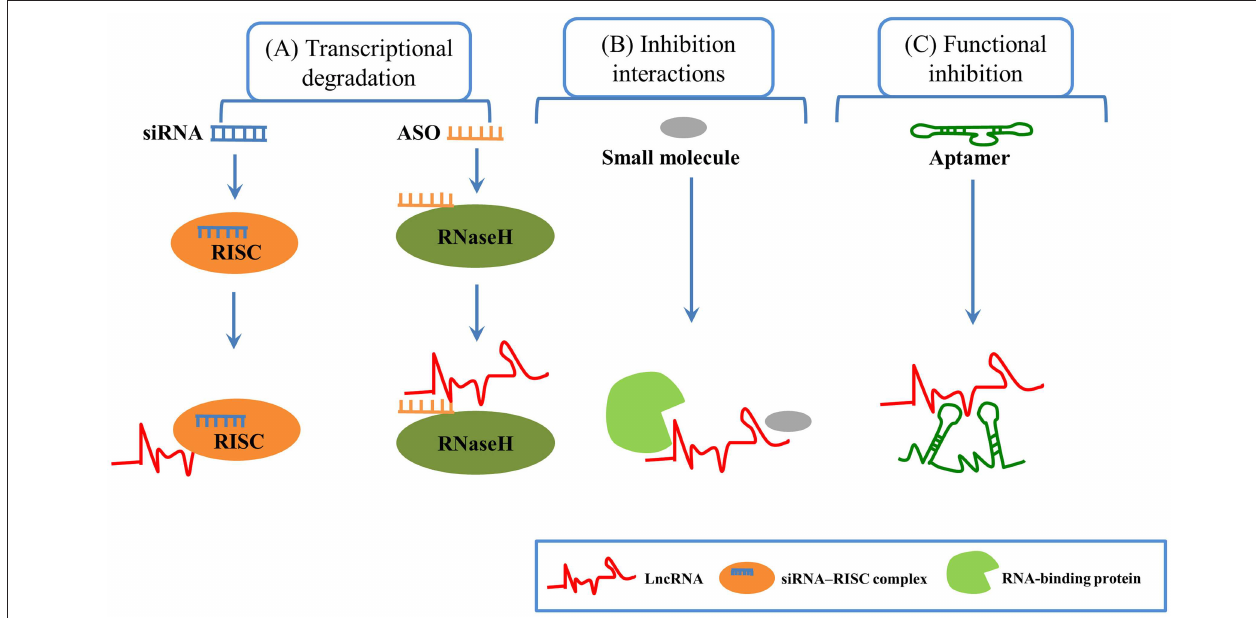
FIGURE 3 | LncRNA-based therapeutic methods in cancer. (A) Transcriptional degradation: Short interfering RNAs (siRNAs), which are double-stranded RNAs, can degrade target RNAs through RISC (RNA-induced silencing complex). Antisense oligonucleotides (ASOs), which are single-stranded oligonucleotide sequence, offer specific complementarity, and Rnase H-mediated degradation of target lncRNA. (B) Inhibition interactions: Small molecules can inhibit the interaction between lncRNAs and protein. (C) Functional inhibition: Aptamers (short RNA or DNA oligonucleotides with 3-dimensional structure) can bind to their target lncRNAs at specific structural